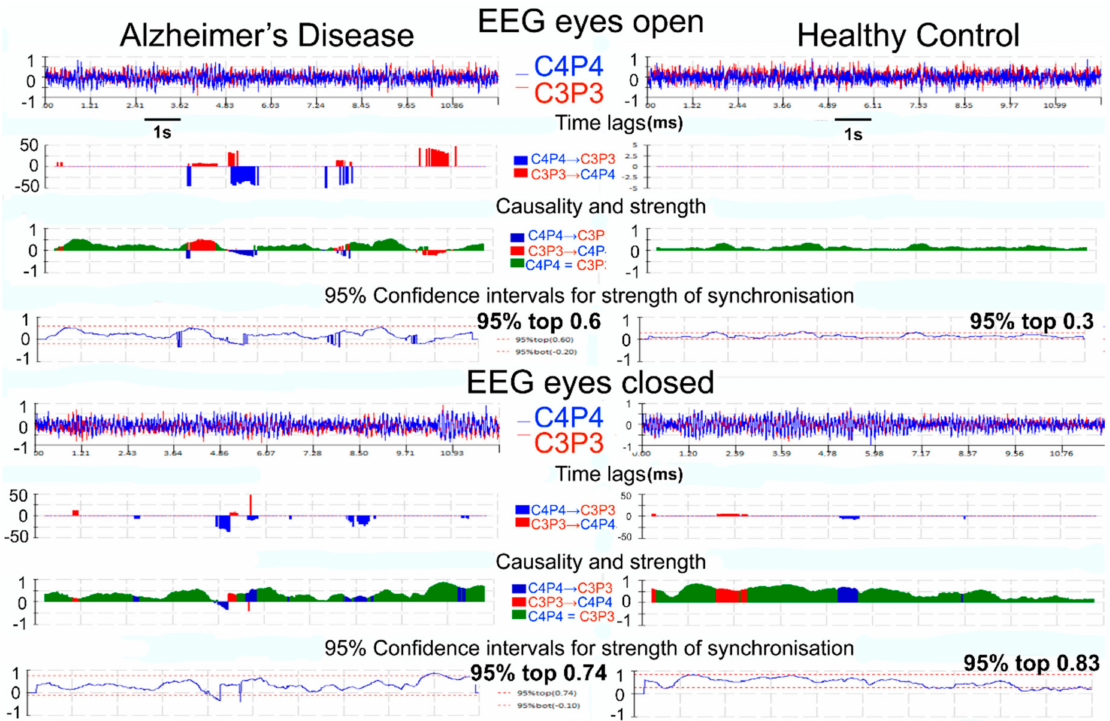
Figure 1. This figure illustrates the results of our novel QEEG method, the EER-causality test. The figure includes screen shots taken from the software results screen. The data included are from one participant with AD on the left and a HC on the right. The top half of the panel is from the eyes open (EO) state and lower panel from eyes closed (EC) state. Each EC and EO resting state contains 12 s EEG epochs. For each EO and EC state, AD ( left ) and HC ( right ), row one shows the normalized EEG data from the homologous centroparietal areas, row two the time lag estimates (not used in our current work), row three the strength of synchronization (causality: degree of association between the centroparietal EEG time series), and row four the 95% confidence intervals for the strength of synchronization. The color-coding indicates the direction of synchronization; blue = right drives left, red = left drives right, green = isochronous zero-lag synchronization. Please note that in the EO state, there are dynamic fluctuations in the level of synchronization with peaks of causality exceeding 0.5 in the AD participant, not seen in the HC example. These fluctuating bursts of high-level synchronization are captured with our dynamic methodology and they are best expressed in the 95% confidence intervals of the strength of